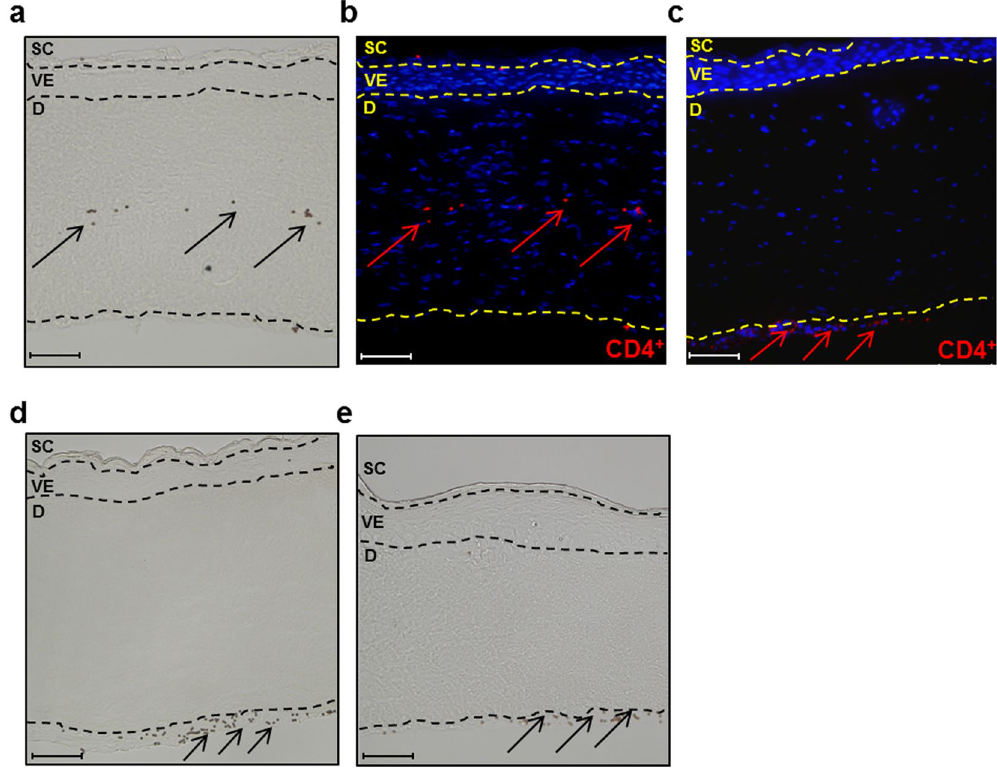
Figure 4. CD4 + T cell migration occurs exclusively in filaggrin-deficient ( FLG − ) skin equivalents. ( a ) Representative light microscopy picture of a FLG − skin equivalent containing migrated T cells attached to magnetic beads (arrows). ( b ) Corresponding immunostaining against CD4 + T cells (red), counterstained with DAPI (blue), scale bar = 100 µ m. ( c ) Immunostaining against non-activated CD4 + T cells (red, arrows) in FLG − skin equivalents, counterstained with DAPI (blue). Representative light microscopy picture of ( d ) a normal ( FLG + ) skin equivalent and ( e ) FLG − skin equivalents generated from keratinocytes transfected with siRNA negative control after exposure to activated T cells (arrows, attached to magnetic beads; scale bar = 100 µ m, SC = stratum corneum, VE = viable epidermis, D =